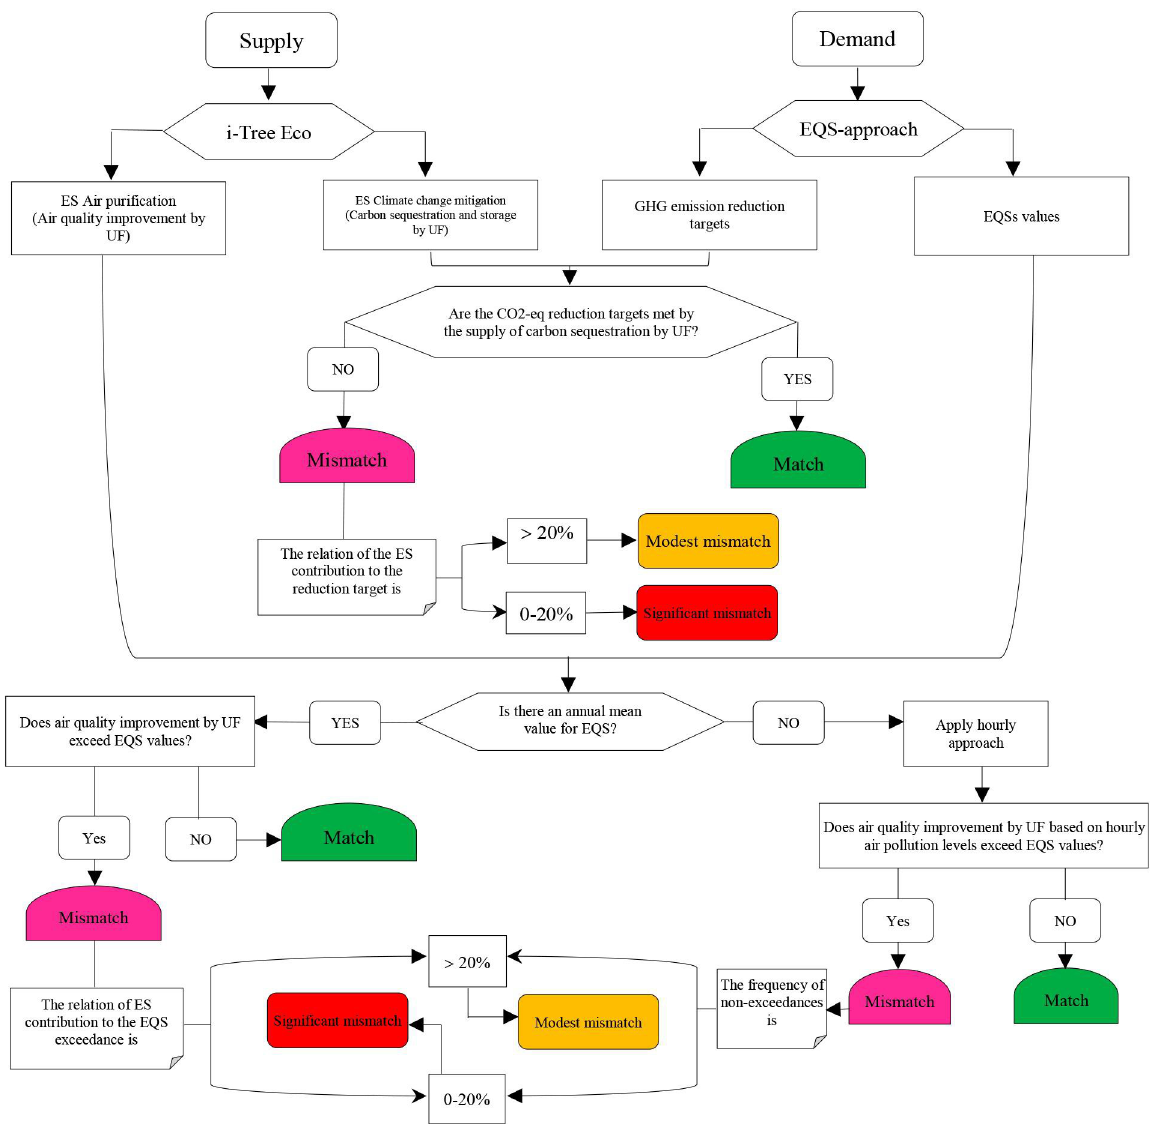
Fig 5. Flowchart for identifying and assessing matches and mismatches between the supply and demand of urban regulating ecosystem services